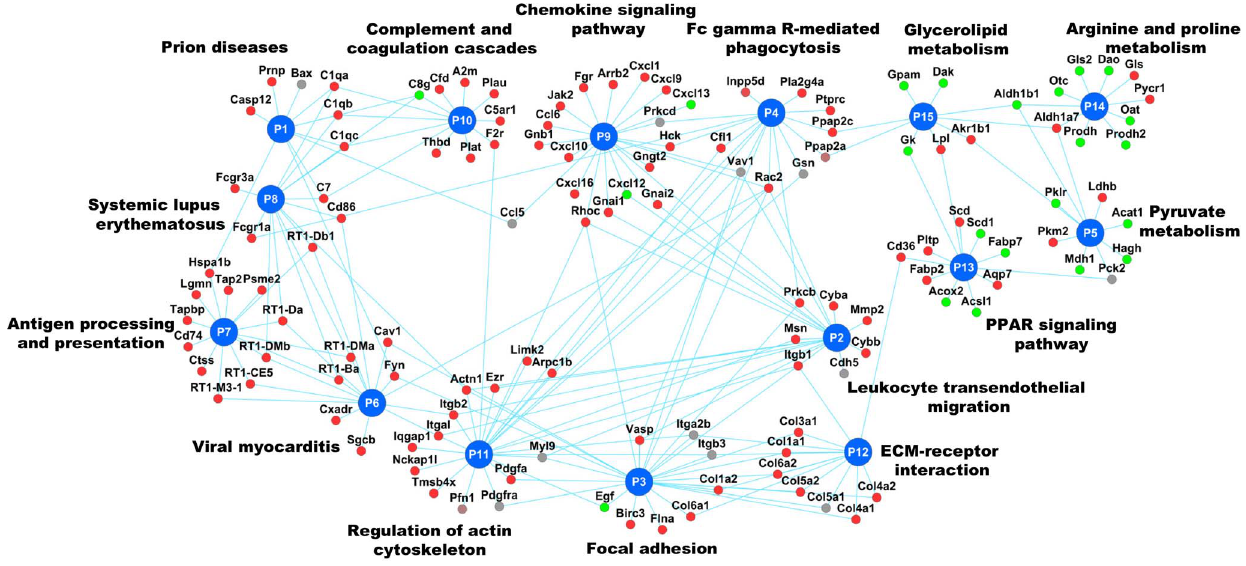
Figure 3. Genes that mapped to the enriched Kyoto Encyclopedia of Genes and Genomes (KEGG) pathways. The average log 2 fold- change ratio across chemical exposures that produced periportal liver fibrosis was used as the gene expression value. Genes with average log 2 fold- change ratios . 0.6 are colored in red. Genes with average log 2 fold-change ratios ,2 0.6 are colored in green. Genes whose average log 2 fold- change ratios are between 0.6 and 2 0.6 are colored in grey.